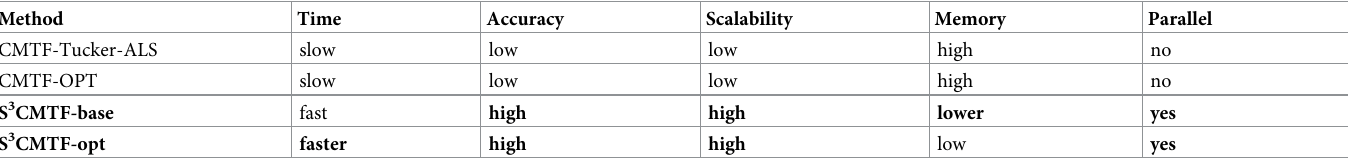
Table 1. Comparison of our proposed S 3 CMTF and the existing CMTF methods. S 3 CMTF outperforms all other methods in terms of time, accuracy, scalability, mem- ory usage, and parallelizability.